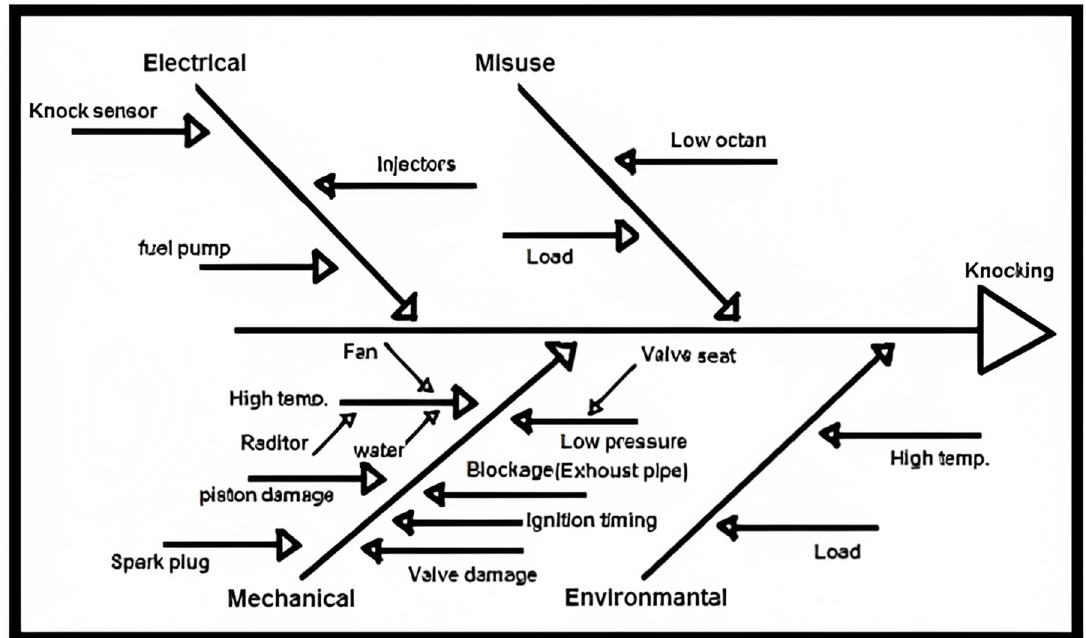
Figure 20. Factors that contribute to